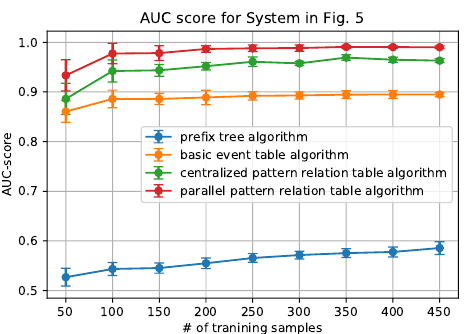
Figure 7. F-1 score for System in Figure 4.